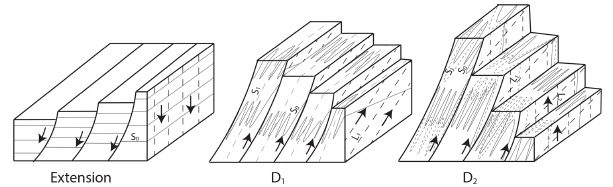
Figure 21. Conceptual model of the structural development of the